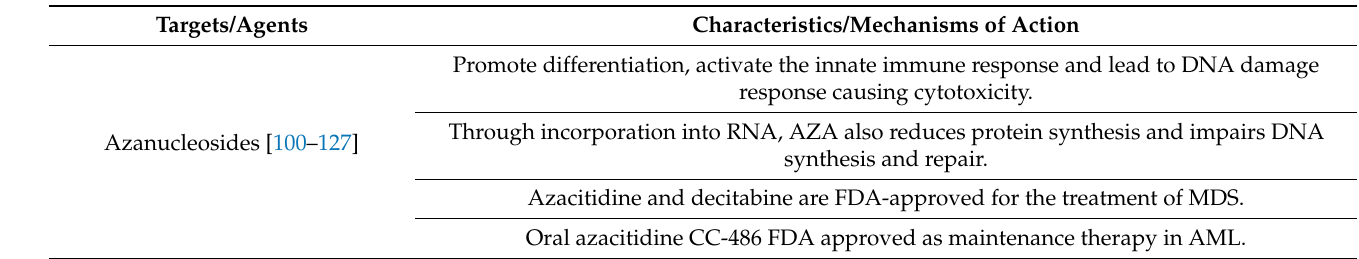
Figure 2. Overview of epigenetic drugs for MDS and sAML therapy. Many epigenetic enzymes are involved in the regulation of gene function. These can be broadly classified into “writers”, which add specific marks to core histones, namely methyl (me) and acetyl (ac) groups; “readers”, which identify the marks; and “erasers”, which remove these marks. DNA methyltransferases (DNMTs) methylate DNA, thereby silencing certain tumor suppressor gene expression. Hypomethylating agents, such as azanucleosides, are thought to reduce DNMT activity, thus reactivating silenced genes. Histone methyltransferase (HMT) inhibitors (inh) that target mutated PRMT5, DOT1L and EZH2 seek to re-stabilize perturbed histone methylation states. Histone deacetylase (HDAC) in- hibitors restore histone acetylation, thus activating gene expression to promote differentiation and apoptosis. Ten-eleven translocation (TET) enzymes catalyze the demethylation of 5-methylcytosine to 5-hydroxymethylcytosine to induce active DNA demethylation. Isocitrate dehydrogenase (IDH) inhibitors reduce total serum levels of the oncometabolite, 2-hydroxyglutarate, restoring normal TET2 activity and DNA and histone methylation levels. Bromodomain and extra-terminal domain (BET) inhibitors mainly target BRD4, which normally promotes transcription of oncogenes, such as MYC, by binding acetylated histones. Table 2. Current epigenetic drugs in the treatment of myeloid